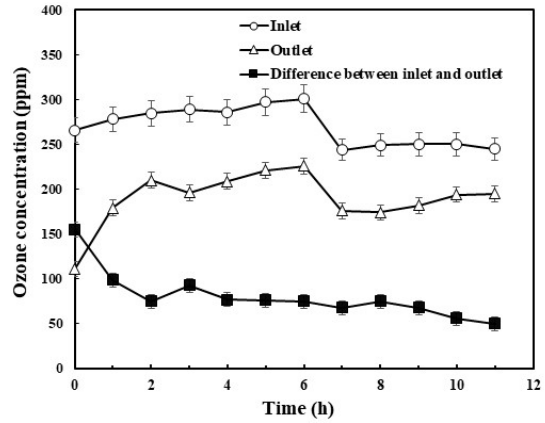
Figure 1. Inlet and outlet ozone concentrations at different intervals during extracellular polymeric substances (EPS) ozonation.